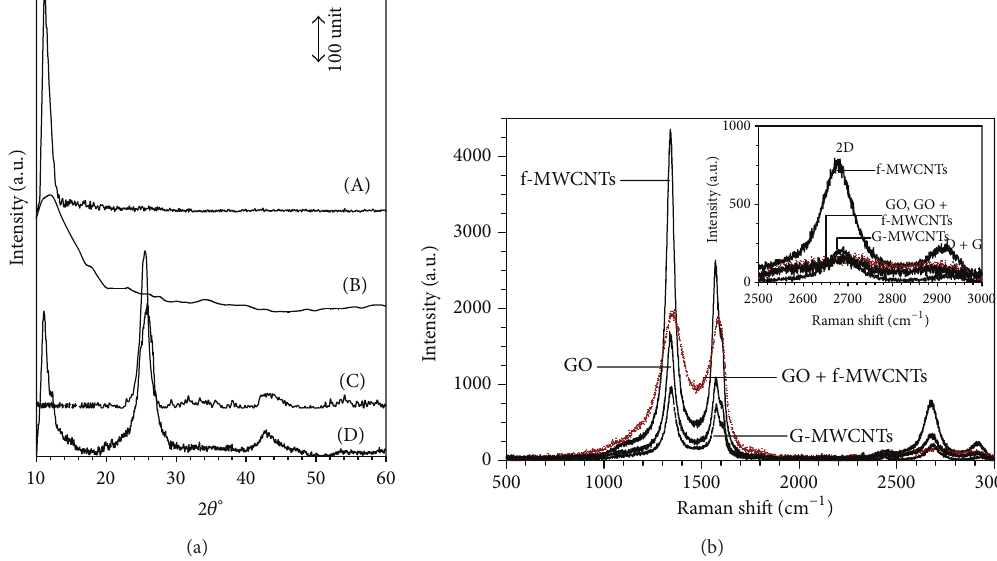
Figure 4: (a) X-ray diffractograms of GO (A), GO + f-MWCNTs (B), f-MWCNTs (C), and G-MWCNTs (D). (b) Raman spectra of f- MWCNTs, GO + f-MWCNTs, GO, and G-MWCNTs, from the top to the bottom, respectively; (b) inset shows the Raman spectra at an expanded scale to manifest the 2D and D + G